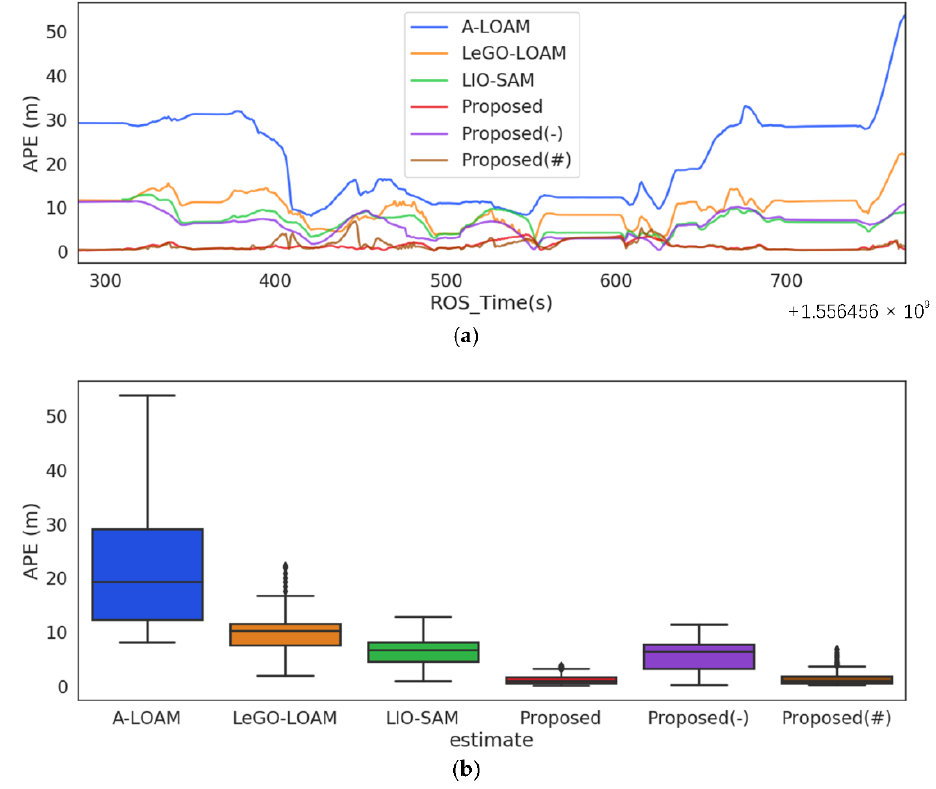
Figure 13. Comparison of the positioning error of each algorithm. ( a ) APE fitting curve. ( b ) The box diagram of APE.